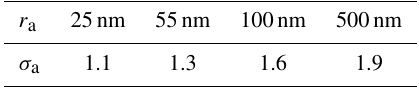
Table 1. Choices of the dry aerosol parameters r a and σ a